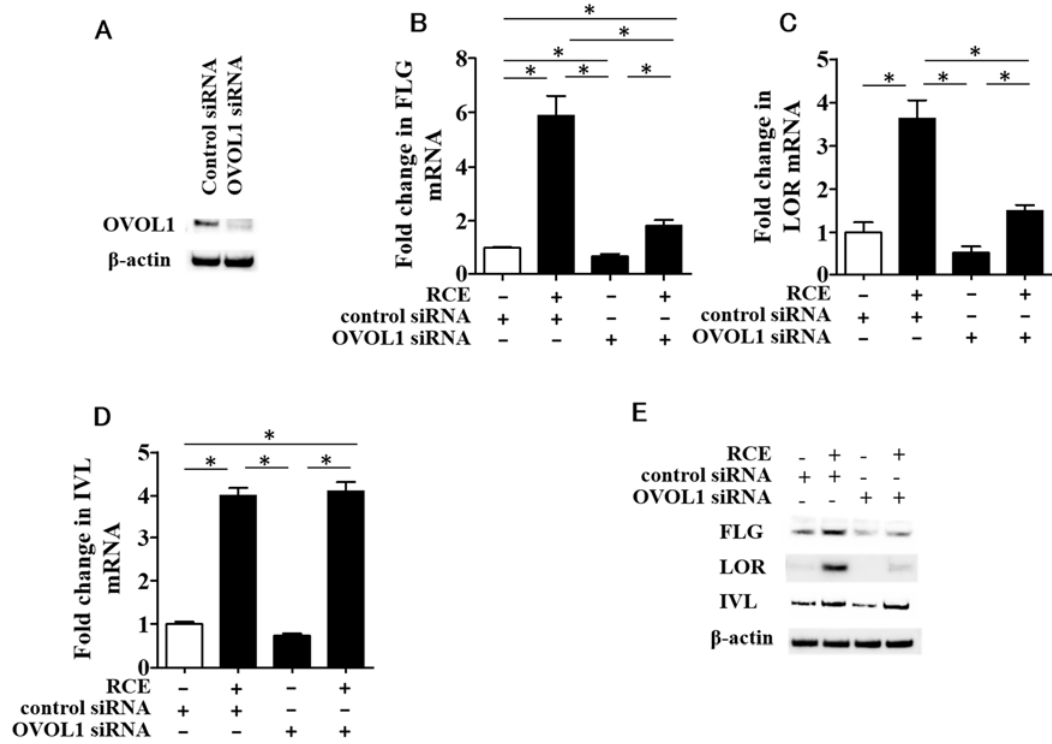
Figure 5. ( A ) Protein level of OVOL1 is downregulated in keratinocytes transfected with OVOL1 siRNA; ( B ) RCE-induced FLG upregulation is canceled in OVOL1-knockdown keratinocytes; ( C ) RCE-induced LOR upregulation is canceled in OVOL1-knockdown keratinocytes; ( D ) RCE-induced IVL upregulation is not canceled in OVOL1-knockdown keratinocytes; ( E ) The RCE-induced FLG and LOR , but not IVL , protein upregulation is canceled in keratinocytes transfected with OVOL1 siRNA. White bar expresses DMSO control. Data are expressed as mean ± SEM ( n = 3). *: p < 0.05. RCE = 100 μ g/mL.